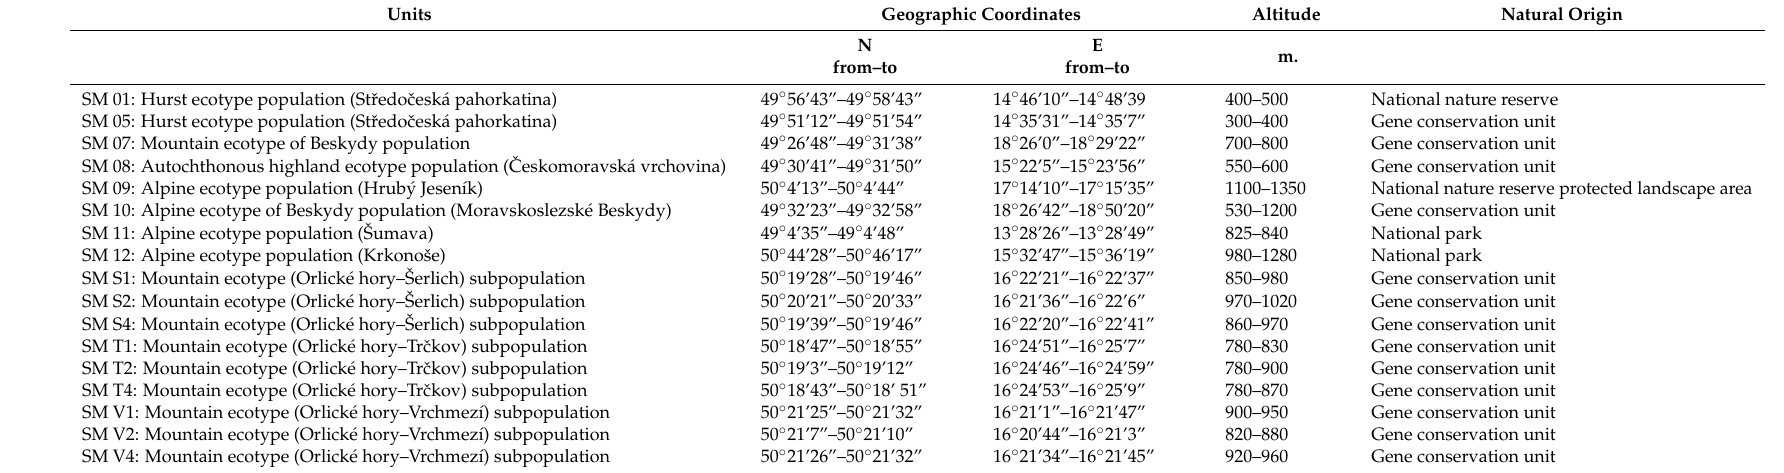
Table 1. Geographic coordinates of the Picea abies